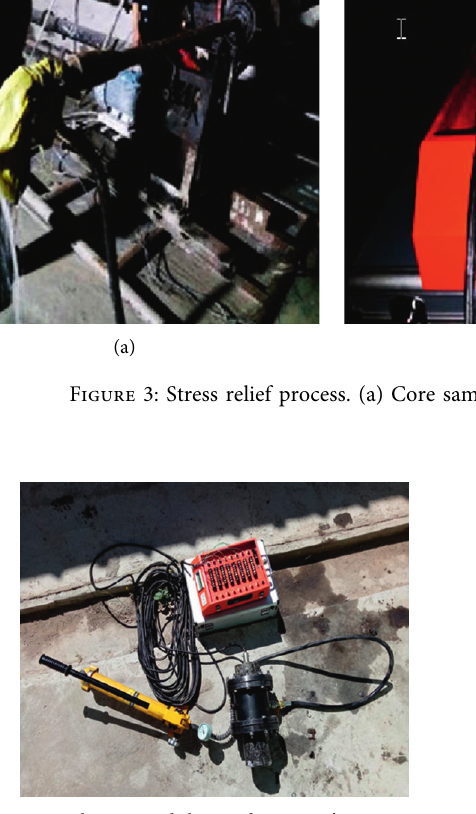
Figure 4: Core elastic modulus and Poisson’s ratio acquisition. Table 1: σ max and σ c at different measurement